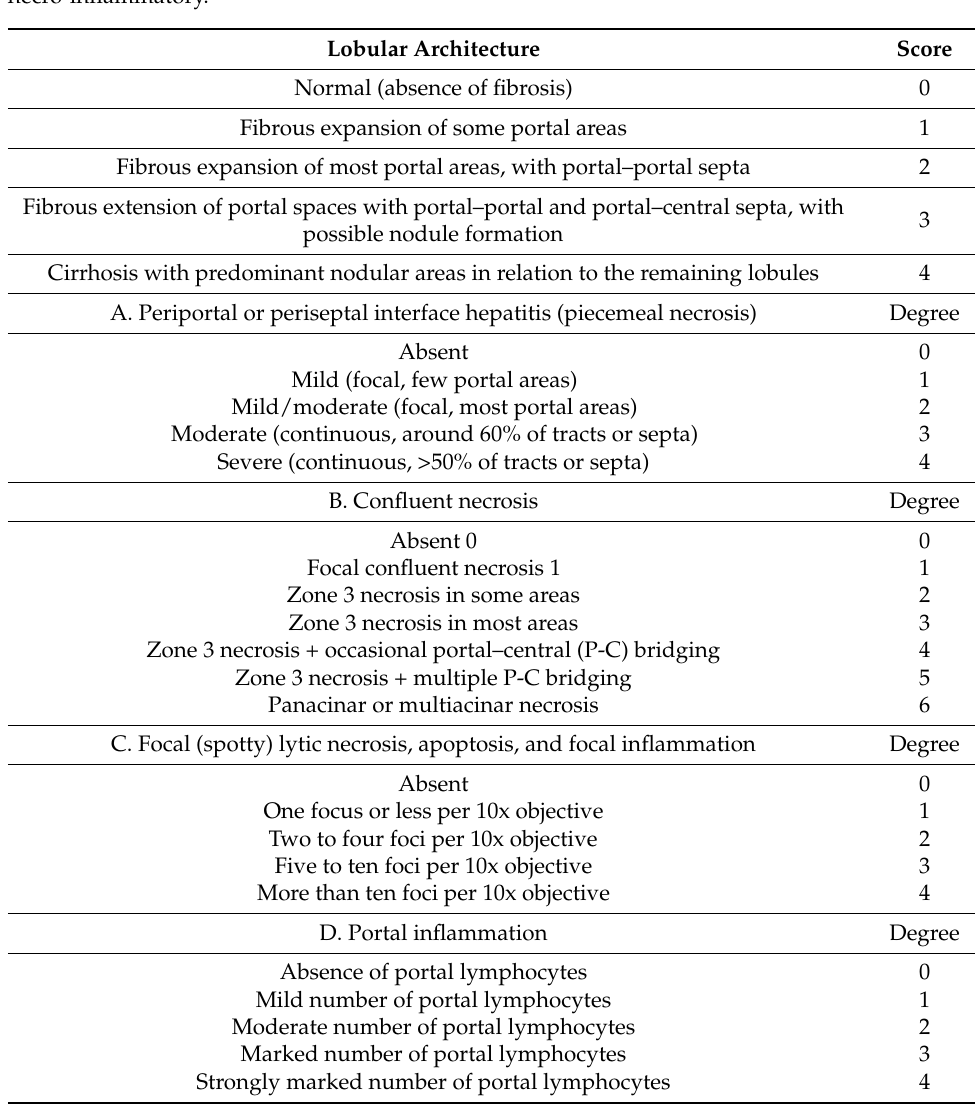
Table 3. Scoring features for lobular architectural changes and hepatic activity index (HAI) grading: necro-inflammatory. Lobular Architecture Score Normal (absence of fibrosis) 0